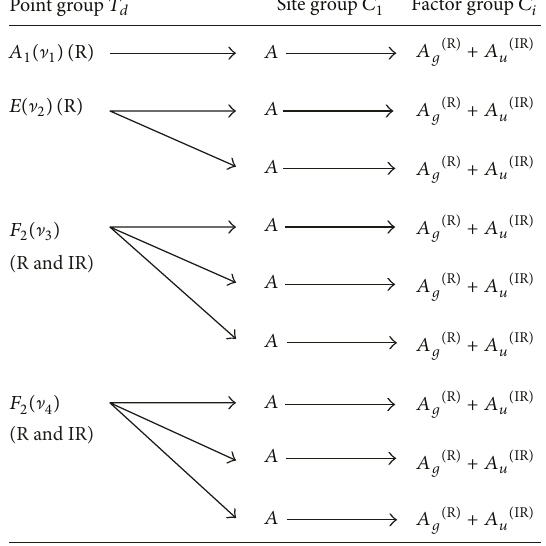
Scheme 1: Correlation scheme for the internal modes of MoO 4 in Na 2 K 2 Cu(MoO 4 ) 3